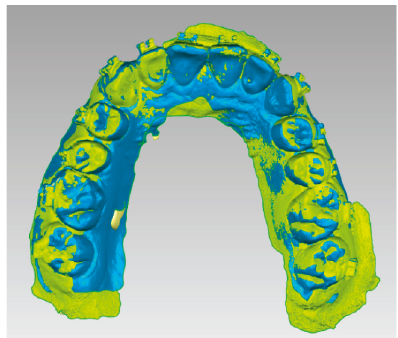
Figure 8: Superimposition of the preoperative and postoperative STL